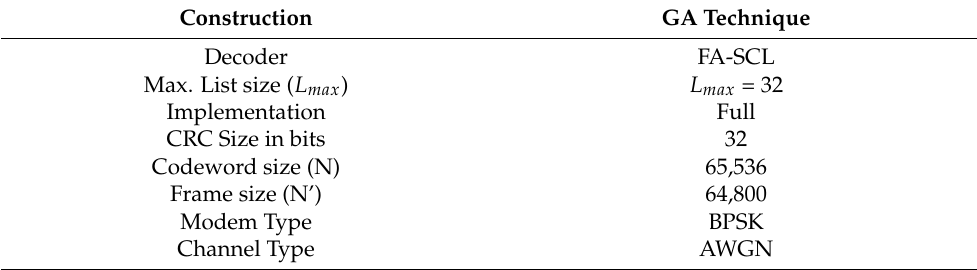
Table 1. Simulation parameters for polar code.